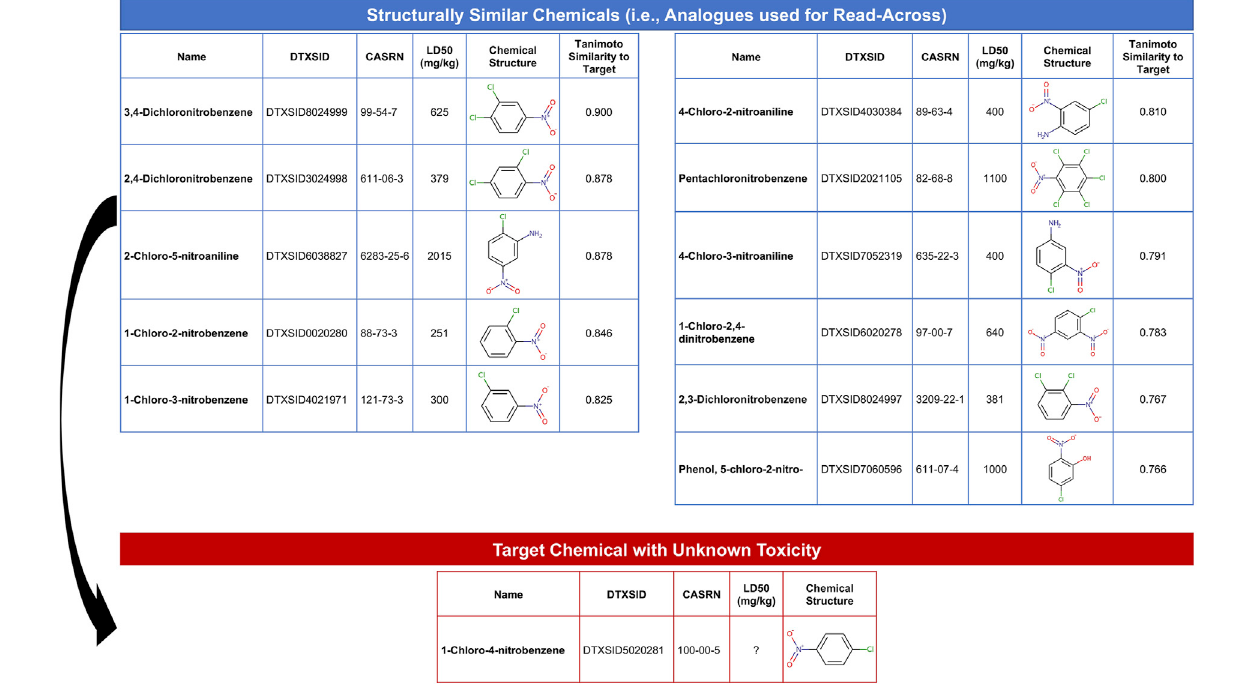
Frontiers in Toxicology |